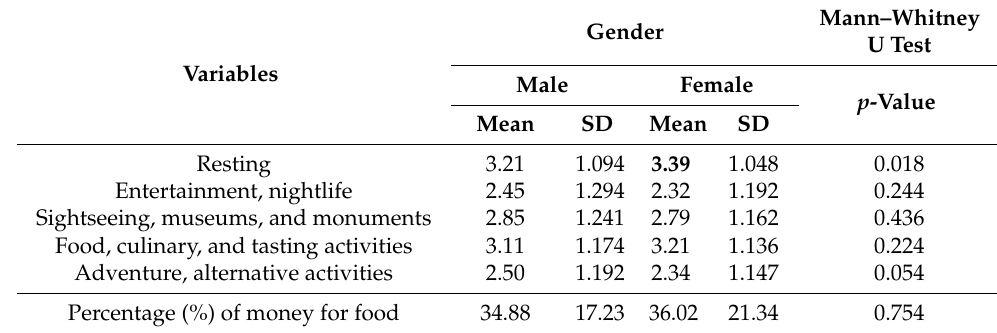
Table 3. Tourists’ activity profile and money spent on